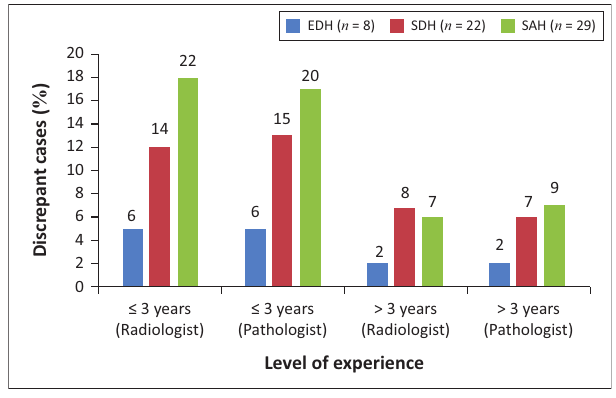
N = 118 (actual number of all discrepant cases). EDH, extradural haemorrhage; SDH, subdural haemorrhage; SAH, subarachnoid haemorrhage. FIGURE 3: Discrepancies and level of experience (in years), South Africa, 2014–